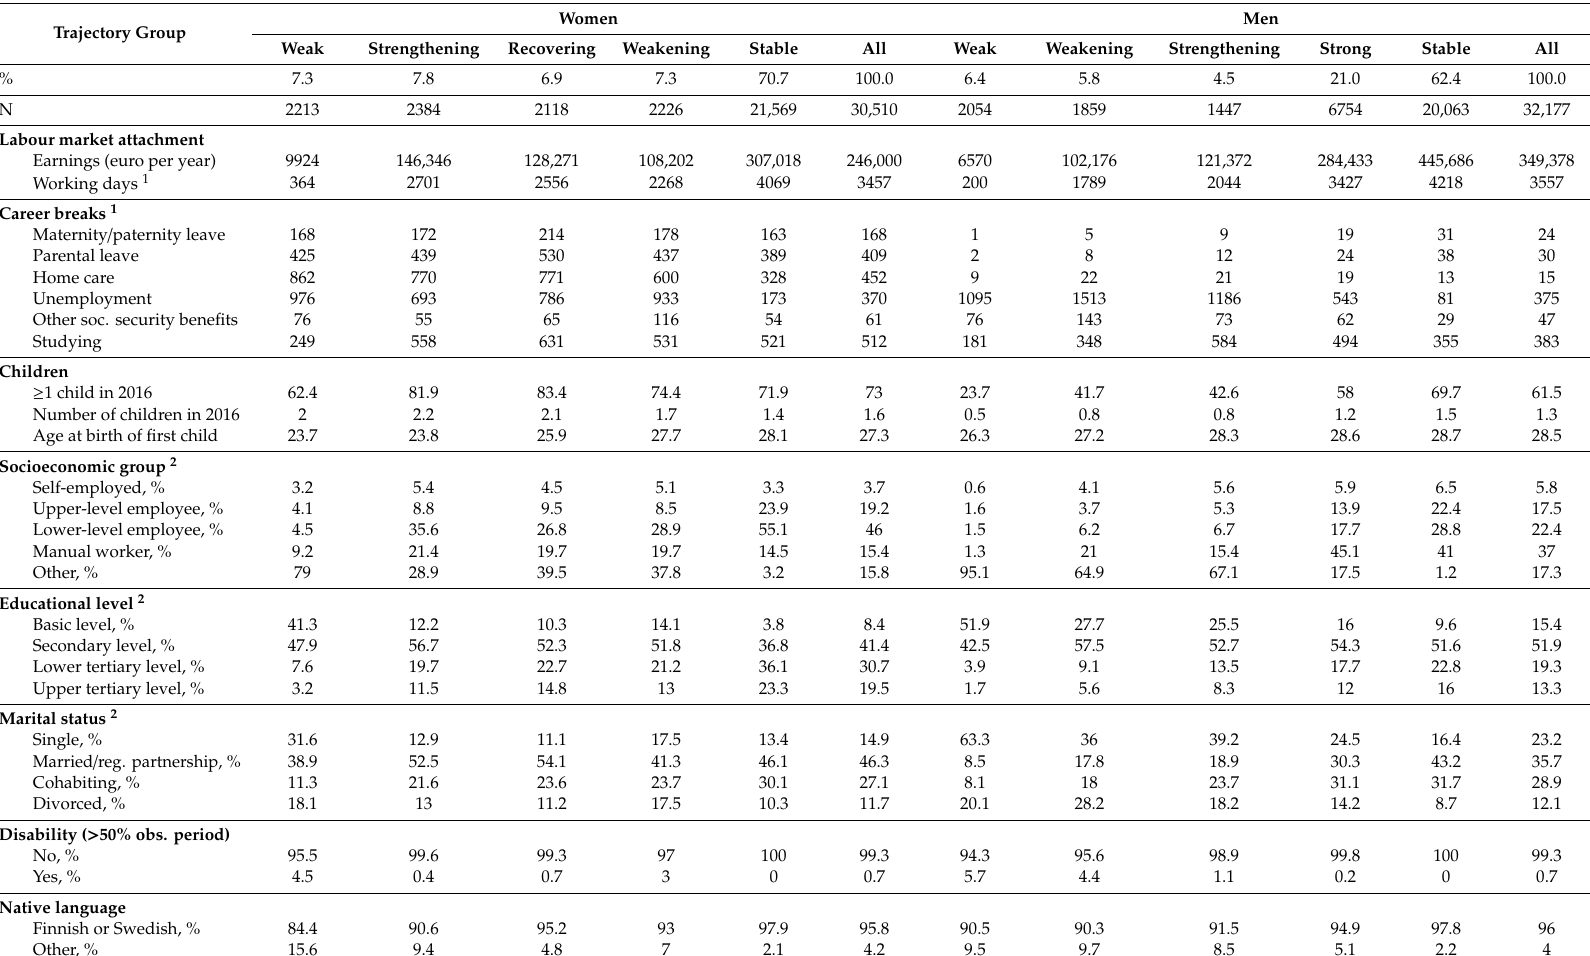
Table 1. Background variables by trajectory group—averages in the observation period